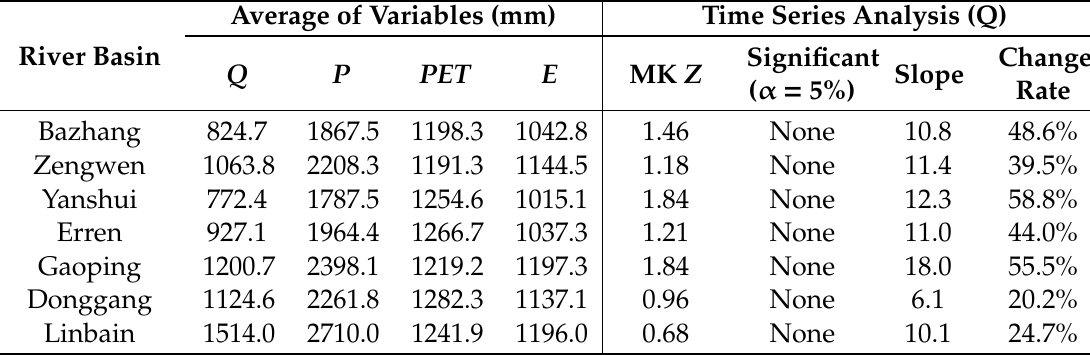
Table 3. Average annual values of each variable and the trend analysis of